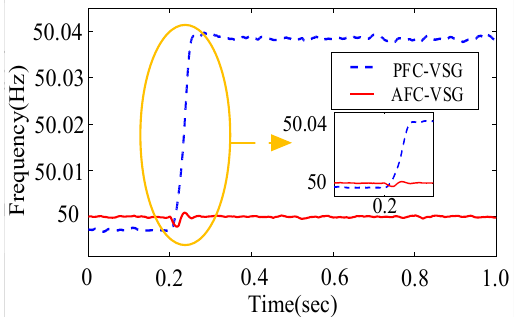
Figure 11. Frequency regulation ability between the PFC-VSG and the AFC-VSG under the sudden load decrease condition.